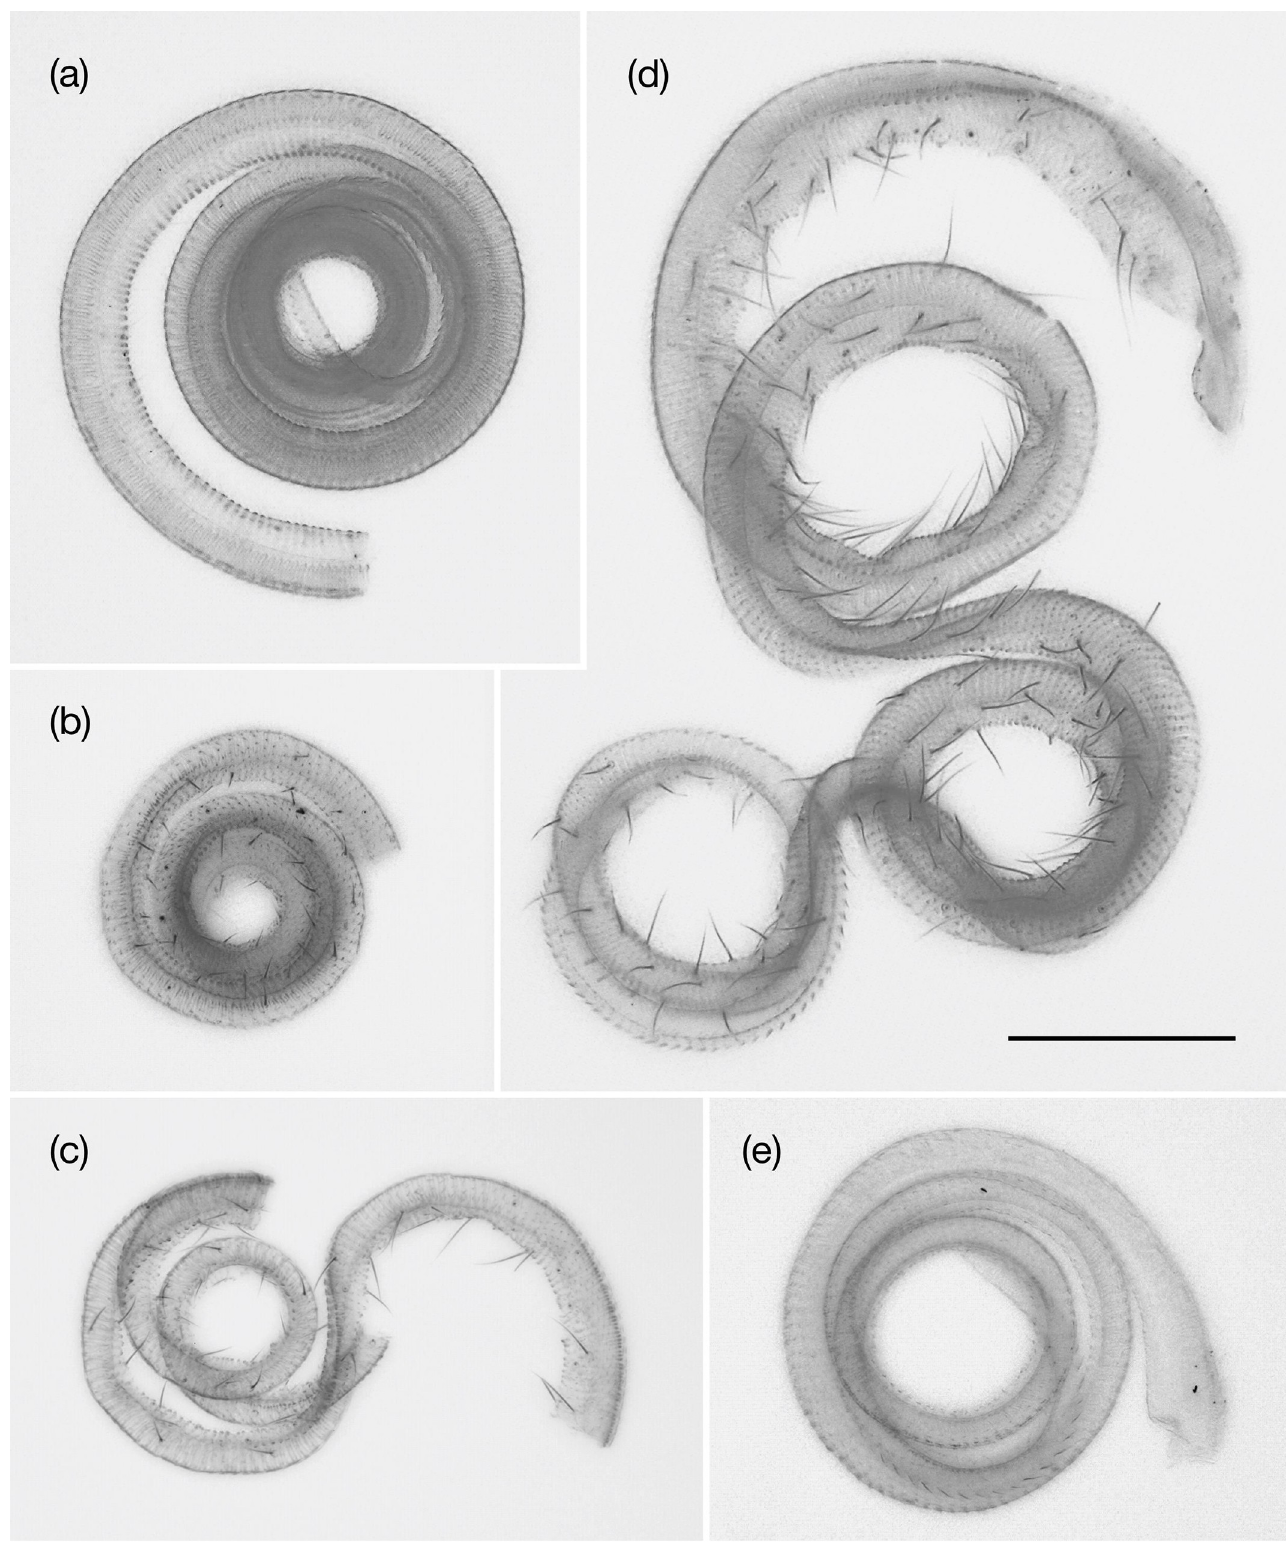
Fig 7. Female proboscis of the five Epicephala species in Peru. (a) E . anomala ; (b) E . acuminatella ; (c) E . graveolensella ; (d) E . huallagensiella ; (e) E . chancapiedra . Because the proboscises were broken during slide preparation, only the distal portions of the proboscises are shown for (b) and (c). Bar = 100 μ m, shared for all photographs.